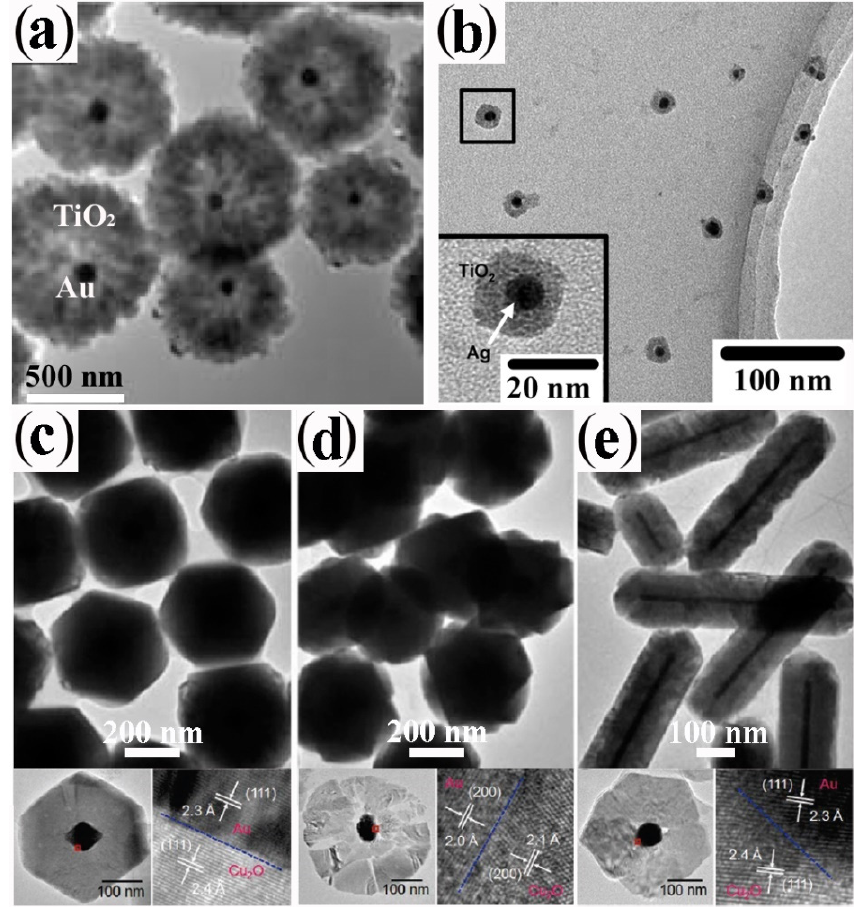
Figure 1. Gallery of representative core@shell CNHSs based on combinations of nonmagnetic transition-metal oxides, produced by direct single- or multiple-step heterogeneous nucleation and growth of the shell onto pre-synthesized nanocrystal seeds (that will represent the cores in the final heterostructures) (cf. Scheme 2a,b). The panels report low-magnification TEM overviews and HRTEM images of: ( a ) Au@TiO 2 nanoreactors with inner void space (adapted with permission from Ref. [62], Copyright Wiley-VCH Verlag GmbH & Co. KGaA). ( b ) Ag@TiO 2 CNHSs (adapted from with permission Ref. [63], Copyright American Chemical Society); ( c – e ) Au@Cu 2 O CNHSs with different core and shell shapes (the smaller bottom panels show cross-sectional views of the relevant interfacial regions (reproduced with permission from Ref. [65], Copyright 2009, American Chemical Society ).